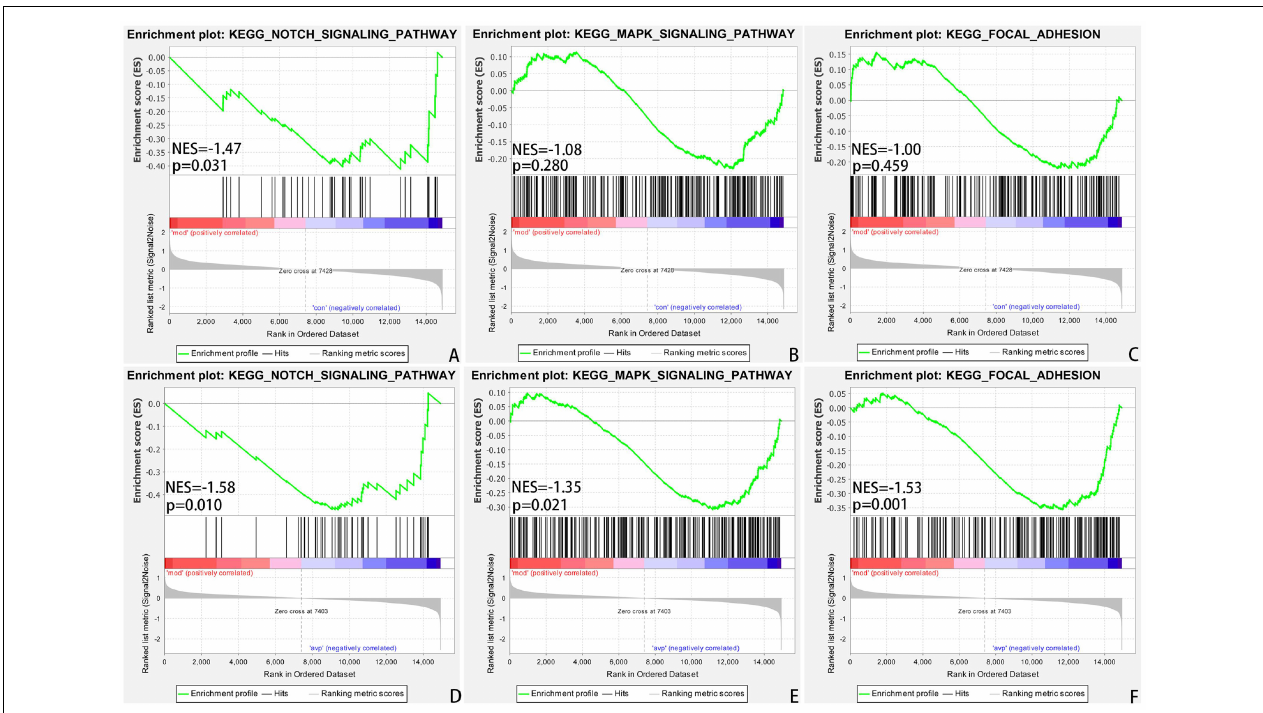
FIGURE 10 | Enrichment of related signaling pathway by GSEA. (A) Notch signaling pathway in control (con) vs. autism (mod). (B) MAPK signaling pathway in control (con) vs. autism (mod). (C) Focal adhesion signaling pathway in control (con) vs. autism (mod). (D) Notch signaling pathway in AVP vs. autism (mod). (E) MAPK signaling pathway in AVP vs. autism (mod). (F) Focal adhesion signaling pathway in AVP vs. autism (mod). The significantly enriched gene set was selected with |NES| > 1 and with NOM p < 0.05.